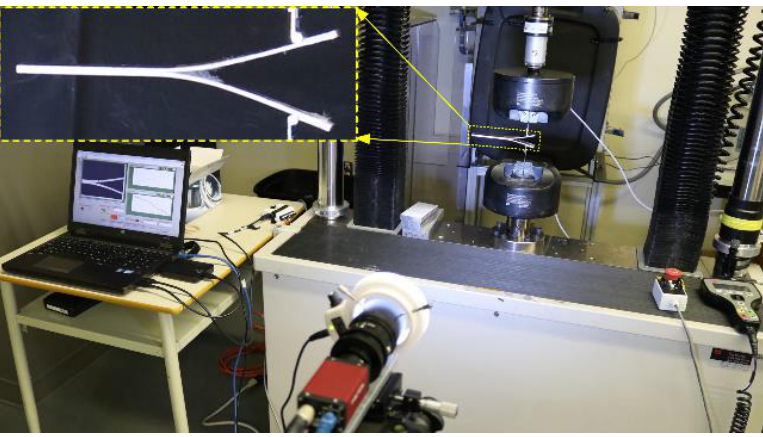
Figure 4. Mode I delamination test setup with a DIC system to follow crack propagation.